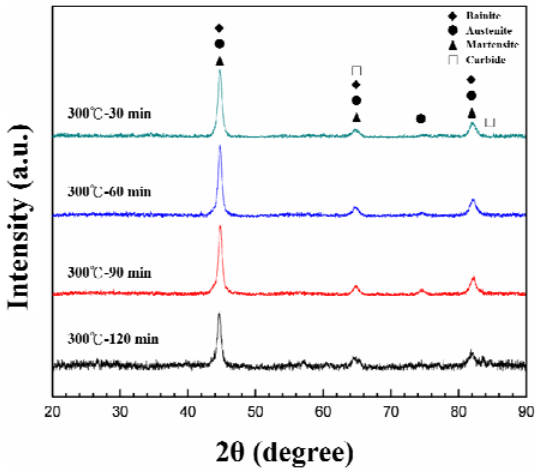
Figure 6. XRD of austempered specimen (1080 °C ‐ 30 min) with a salt ‐ bath temperature of 300 °C and different salt ‐ bath time.